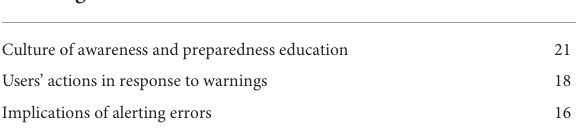
TABLE 4 Top three social challenges to overcome for effective EEW